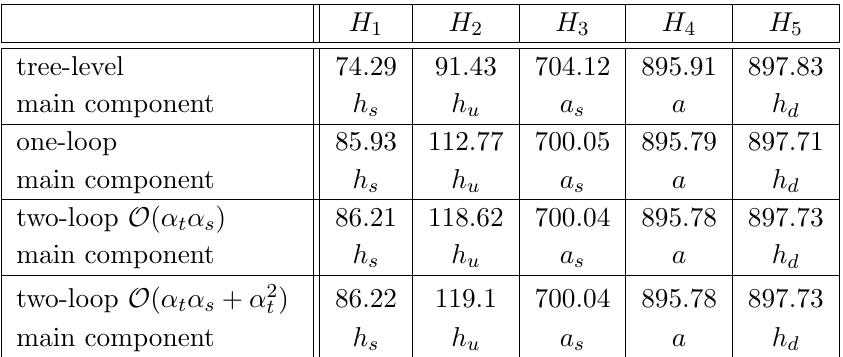
) obtained using DR renormalization in t